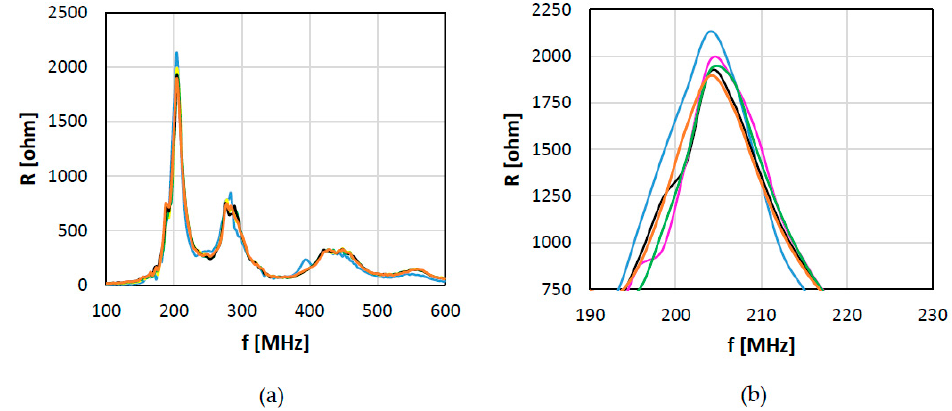
Figure 3. Spectra of R ( a ) and maximum peak values in the restricted range considered for the measurements ( b ), for water ( – ) and water–NaCl mixtures with NaCl molar fraction of 2.3 × 10 − 4 (–), 4.5 × 10 − 4 (–), 1.35 × 10 − 3 (–), and 1.8 × 10 − 3 ( – ).